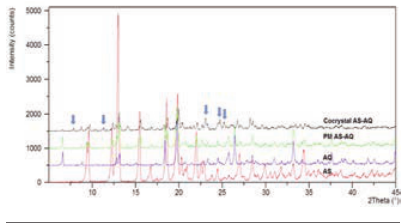
Figure 5. PXRD difractrogram of (A) AS (B) AQ (C) physical mixture AS-AQ (1:1 ekimolar); D) AS-AQ Cocrystal: the new main peak of co crystal.